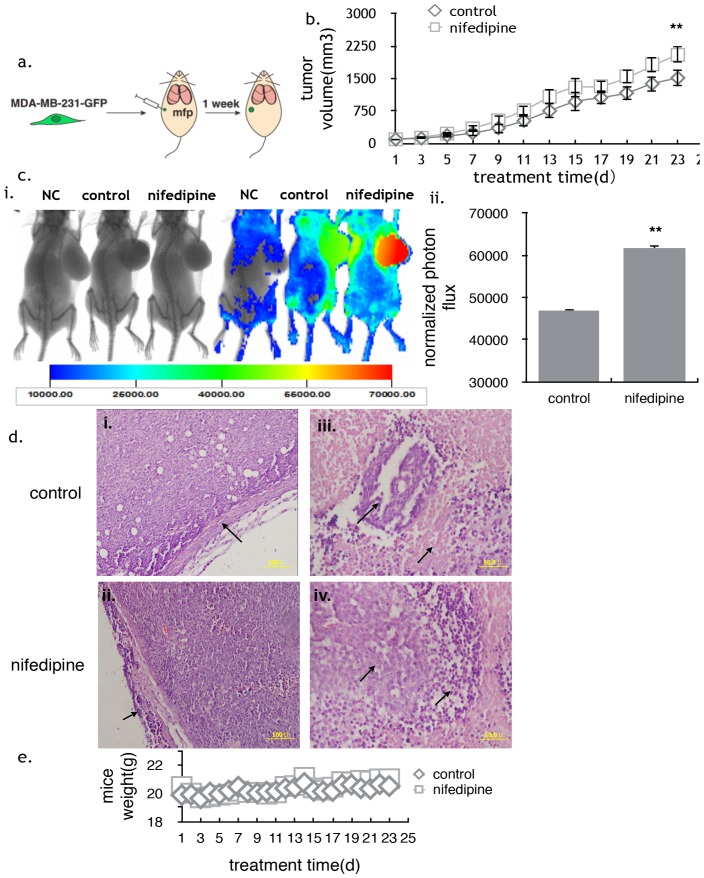
The effect of nifedipine on the nude mice in
vivo.
a) Nude mice were injected with 5106 MDA-MB-231-GFP cells into the second fat pads to imitate the orthotopic breast cancer inoculation. After one week injection, when the breast tumor size reached 100mm3, nude mice were then fed with nifedipine (4.8 mg/kg) or CMC-Na. b) The tumor volume in nude mice described in (a) was measured at the indicated time points and plotted as the mean volume ± SEM; n = 10; P<0.01, Mixed Model in SAS software. c) In vivo imaging of tumors treated with nifedipine or CMC-Na after three weeks(n = 10). i) Nifedipine groups had stronger fluorescence compared with control groups. ‘NC’ represented negative control and it was used to eliminate the background difference. ‘Control’ represented the mice treated with CMC-Na and ‘nifedipine’ represented the mice treated with nifedipine. ii) The normalized photon flux showed that the fluorescence increased about 30%. n = 10; P<0.01,1-way ANOVA. d) HE staining of xenograft in subcutaneous implanted tumor models after the treatment with nifedipine or CMC-Na. i) Control groups had complete envelope. Fewer cancer cells invaded the envelope. ii) Nifedipine groups had uncompleted envelope and tumor cells invaded in skeletal muscles. iii) Control groups had larger tumor cells necrosis and less tumor cells genesis. iv) Tumor cells necrosis and genesis happened at the same time in nifedipine groups (Fig. i and ii magnification ×20; Fig. iii and iv magnification ×40). e) Nifedipine has no effect the weight of nude mice. n = 10; P>0.05, Mixed Model in SAS software.